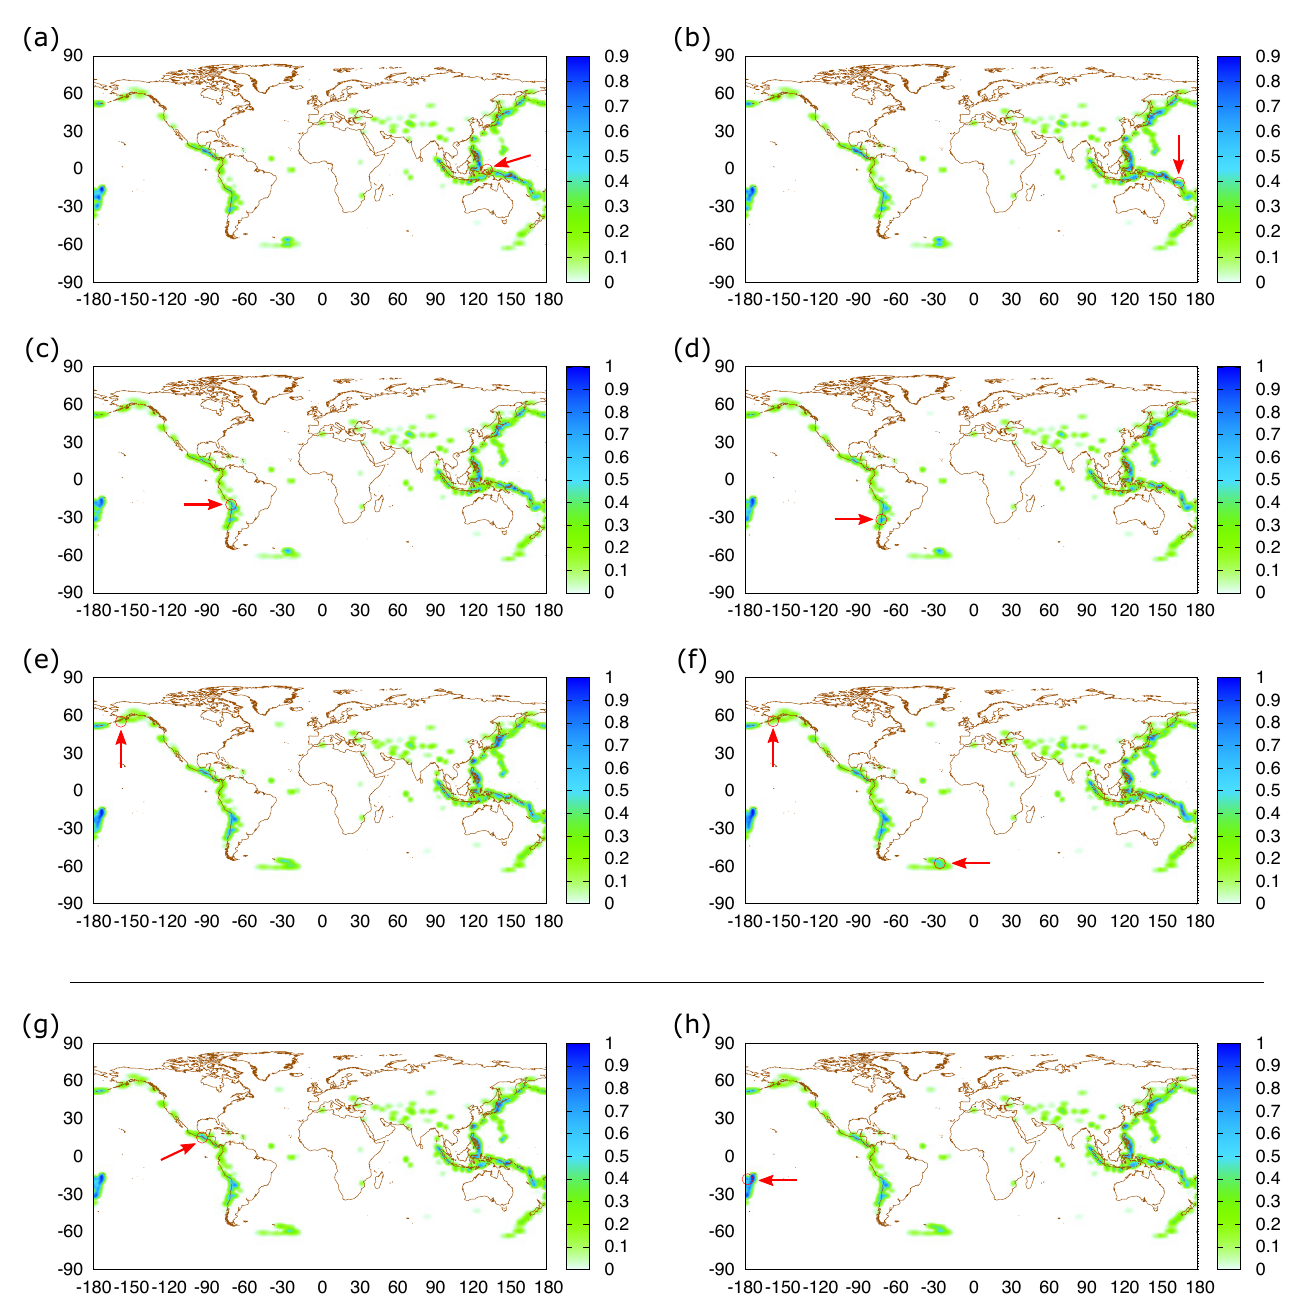
Figure 6. Average EPS maps calculated on the date that β 160 minimizes (see Table 1 and Section 3) for the case of coarse grain radius R = 200 km. Panels ( a – h ) correspond to the M < 8.5 EQs Papua– Indonesia, Solomon Islands, Iquique–Chile, Illapel–Chile, Alaska, Chignik–Sandwich, Chiapas, and Fiji, respectively (see also Table 2). The EQ epicenters are depicted by red circles indicated by arrows for the readers’ convenience. The values of (cid:104) EPS (cid:105) at the grid point closest to each epicenter location vary from 7% to